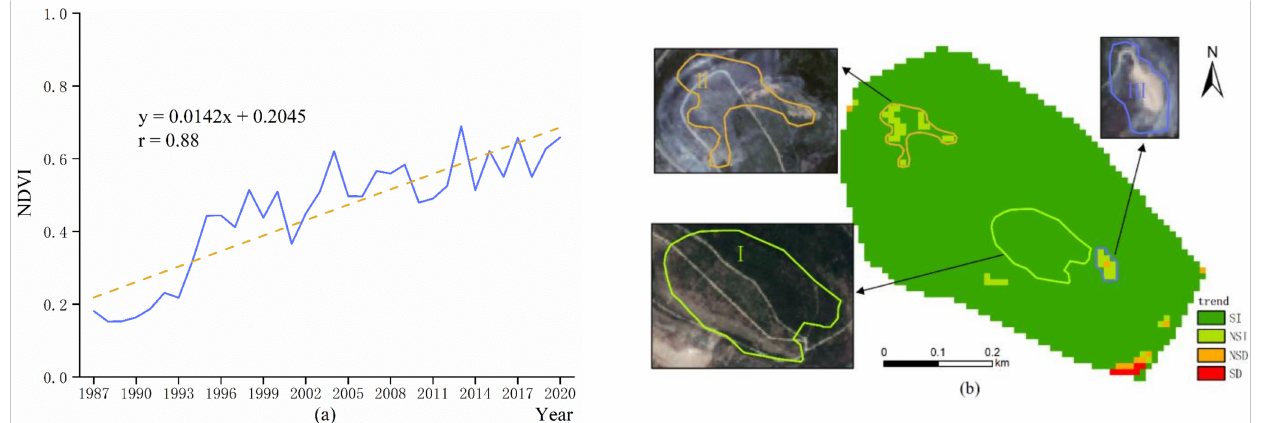
Figure 3. The time series analysis for NDVI on time and spatial scales in the south dump. ( a ) shows the results of the unary regression analysis. And ( b ) shows the results of the Sen+MK trend analysis. SI, NSI, NSD, and SD are, respectively, the abbreviations for significantly increase, not significantly increase, not significantly decrease, and significantly